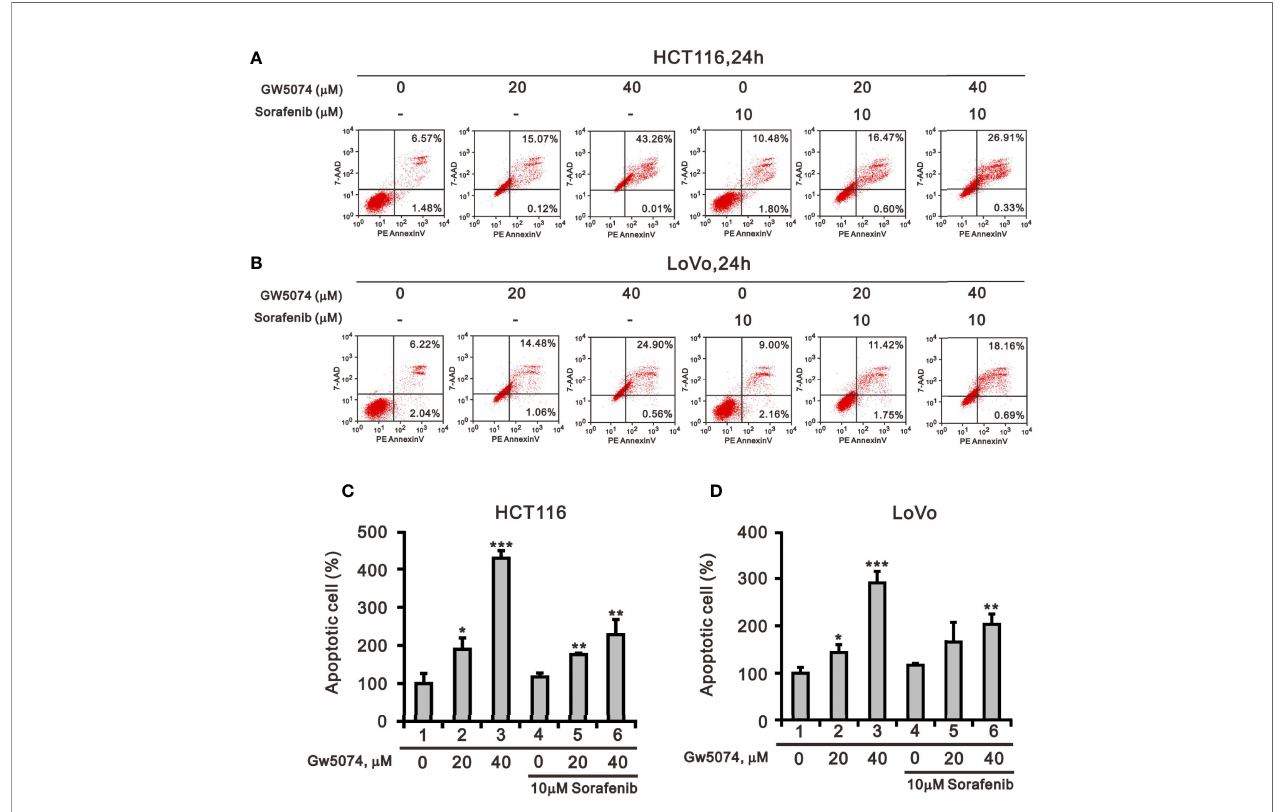
FIGURE 4 | The effects of GW5074 and sorafenib on cellular apoptosis of HCT116 and LoVo cells. HCT116 (A) and LoVo (B) cells were treated with 0, 20, and 40 µM GW5074 in the absence or presence of 10 µM sorafenib for 24 h. They were then subjected to Annexin V apoptosis analysis. Early apoptotic cells are PE Annexin V-positive and 7-AAD-negative, while late apoptotic cells are both PE Annexin V- and 7-AAD-positive. HCT116 (C) and LoVo (D) cells were measured the percentage (early apoptosis plus late apoptosis) compared with vehicle alone (100%). The results are representative of three independent experiments. * p < 0.05, ** p < 0.01, and *** p < 0.001.